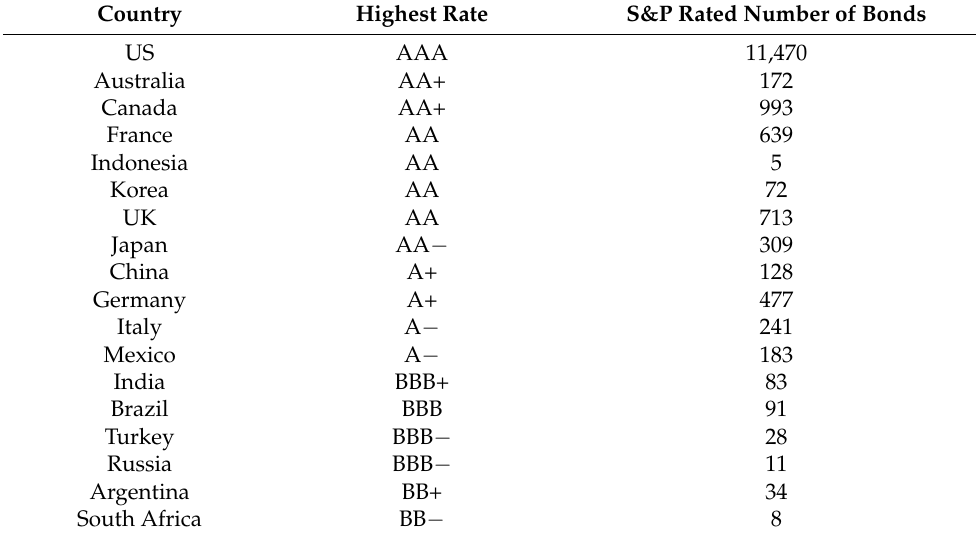
Table 10. Highest S&P ranking & the number of outstanding bonds. (Date: 16 August 2021).